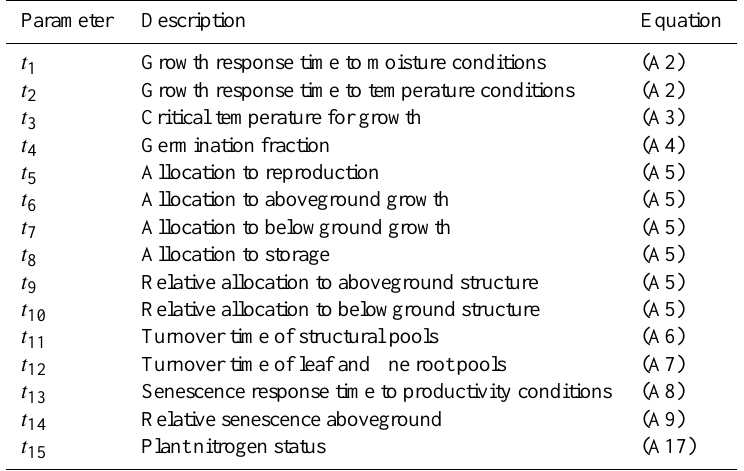
Table C2. Summary of the functional trait parameters. This table summarizes the parameters in the model description which define a plant growth strategy. Column 2 gives a brief description of the effect of this parameter on the plant behaviour and column 3 gives the equation in which the parameter occurs. All of these parameters range between zero and one.